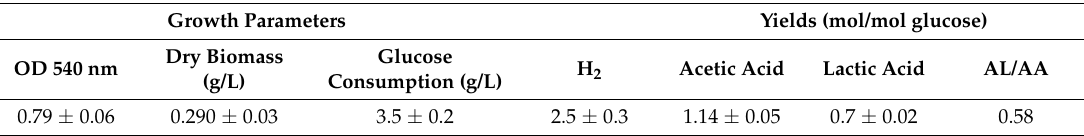
Table 1. Fermentation parameters of Thermotoga neapolitana cultures grown under capnophilic lactic fermentation (CLF) conditions in 3.8 L fermenter for 24